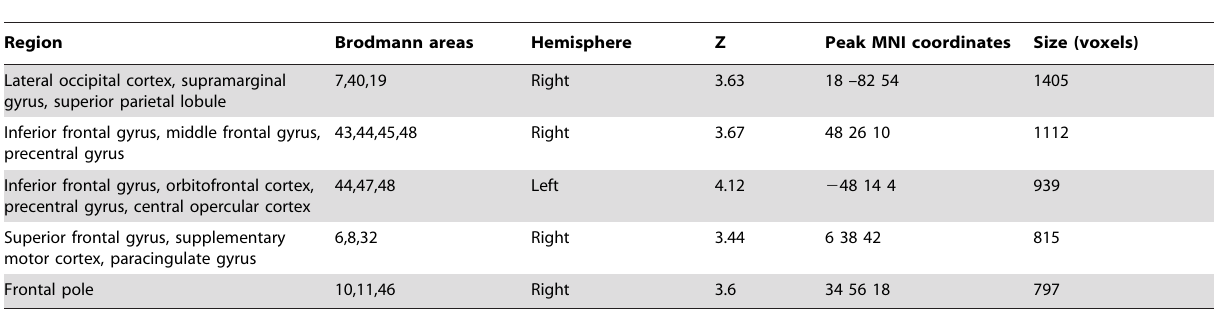
Table 4. Regions displaying greater activation during repetition than baseline conditions (RE).